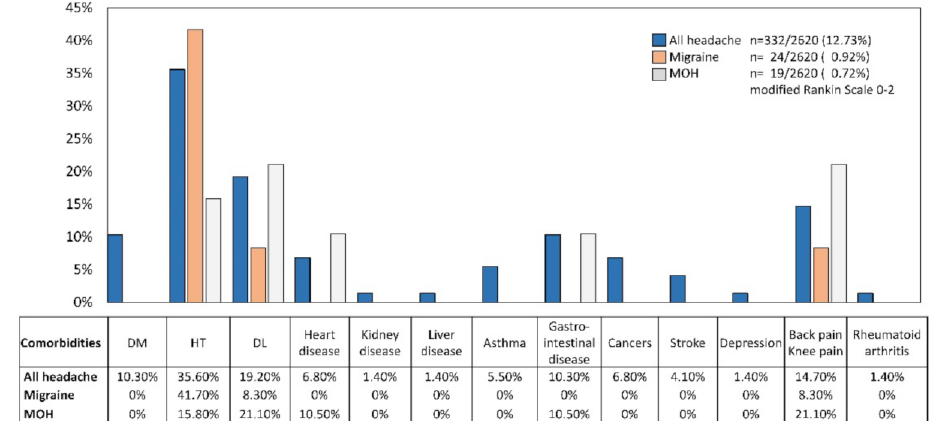
Figure 3. The proportion of comorbidities in all headache disorders, migraine, and medication overuse headache (MOH) respondents. The respondents all lived independently (modified Rankin Scale